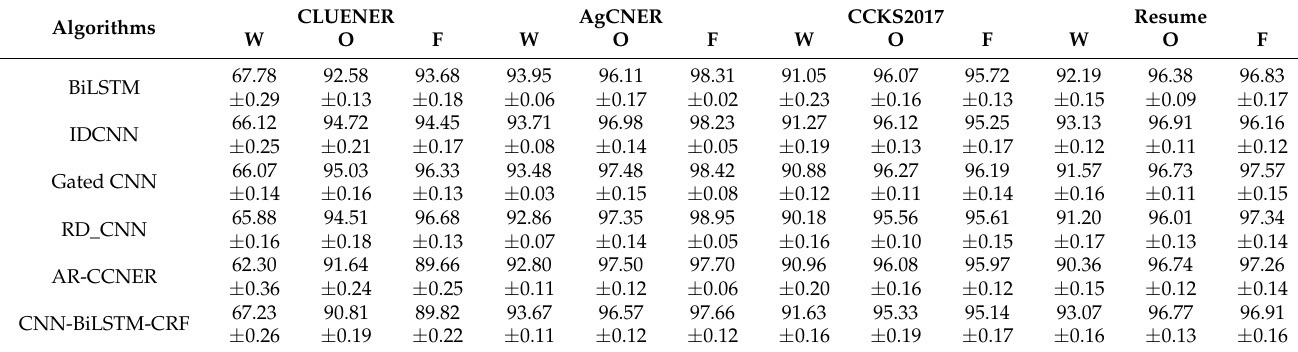
Table 6. F 1 of adversarial training-based models with word2vec, original BERT, and fine-tuning BERT.